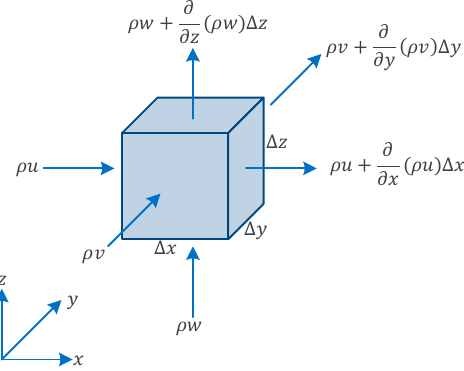
Figure 2. Mass conservation of flows passing through a small rectangular parallelepiped.